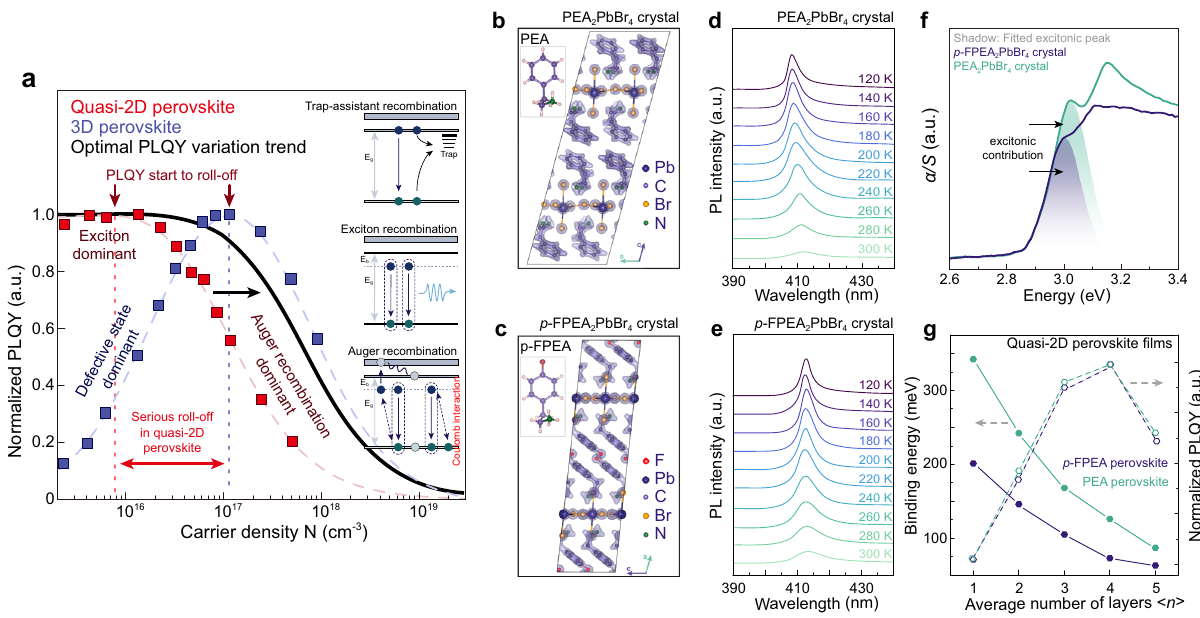
Fig. 1 Characteristics of perovskite single crystals and fi lms. a Experimental PLQYs of quasi-2D perovskite and 3D perovskite fi lms as a function of carrier density; the curves indicates that serious Auger recombination takes place in quasi-2D case compared to 3D one, leading to rapid PLQY declining at a relatively lower threshold of carrier density; the black curve illustrates an ideal PLQY evolution trend for the optimal perovskite emitter which we want to achieve. Lattice structure and corresponding simulated total electron charge density for b PEA 2 PbBr 4 and c p -FPEA 2 PbBr 4 , respectively. d , e Temperature- dependent PL spectra and f absorption spectra of PEA 2 PbBr 4 and p -FPEA 2 PbBr 4 single crystals. g Extracted E b and corresponding PLQYs for PEA and p - FPEA based quasi-2D fi lms with different < n > -values; the PLQYs of the fi lms were obtained under low carrier densities of around 1.2 × 10 15 cm − 3